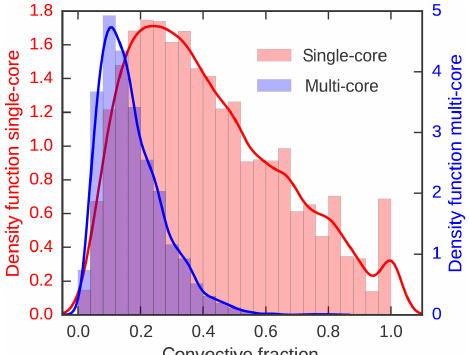
Figure 7. Convective core fraction kernel density estimate (solid line) and histogram for single- (red) and multi-core (blue) systems (AIRS data,